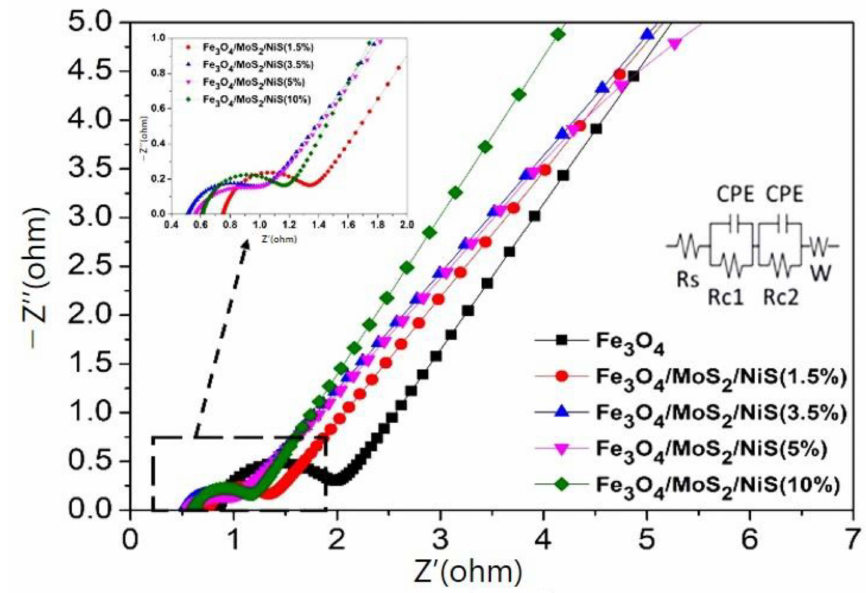
Figure 7. AC impedance spectra of the Fe 3 O 4 electrode and Fe 3 O 4 /MoS 2 /NiS electrodes with different proportions of